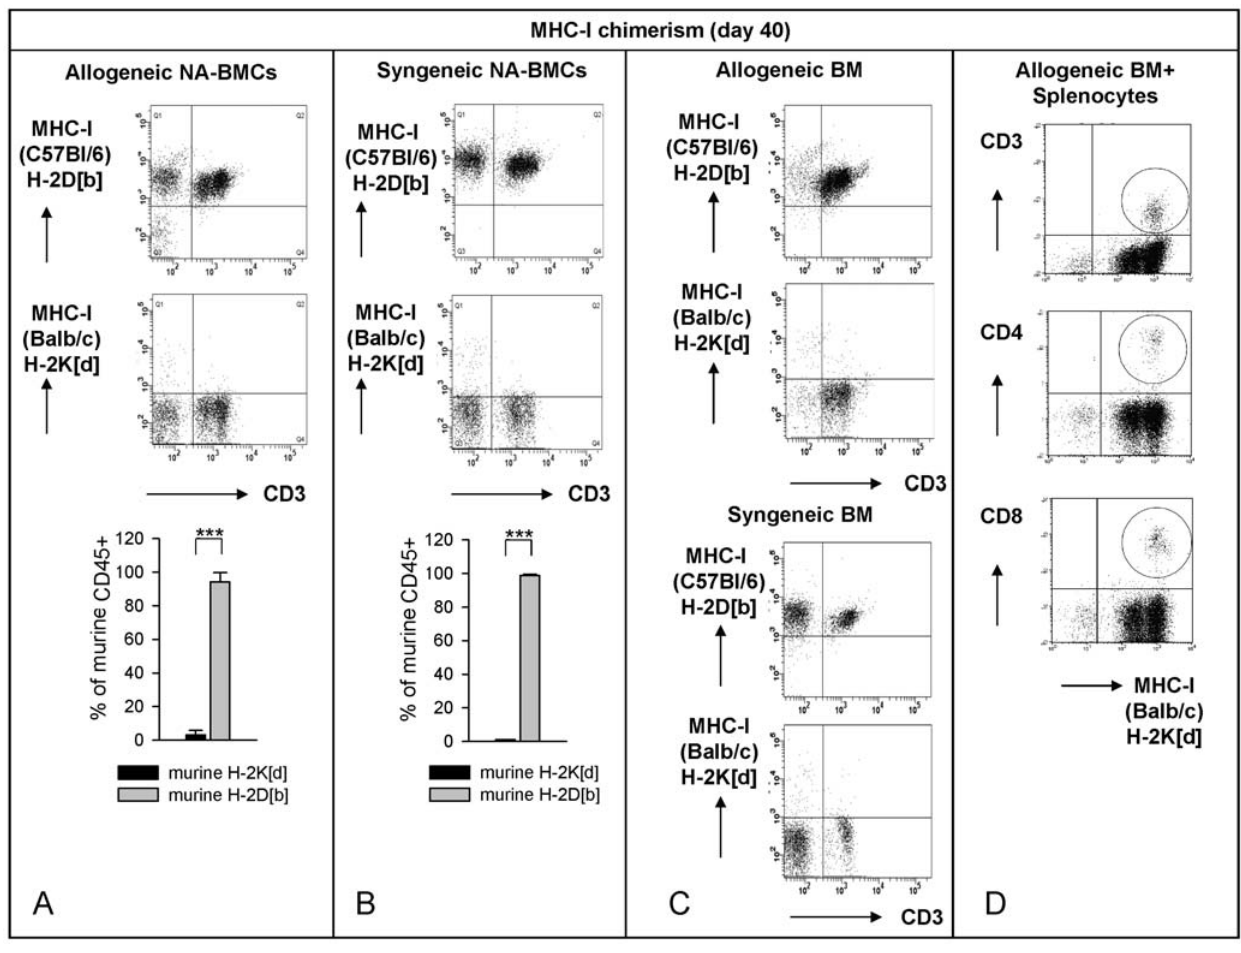
Figure 4. Flow cytometric analysis of MHC-I and CD3 on day -2 before and day 40 after transplantation. MHC-I (H-2D[b], H-2D[d]) and CD3 levels from peripheral blood (gated for lymphocytes) on day 40 after allogeneic NA-BMCs (A), syngeneic NA-BMCs (B) or allogeneic bone marrow (C) transplantation. In co-transplanted animals with allogeneic bone marrow and murine splenocytes we additionally analyze the murine CD4/H-2K[d] and CD8/H-2K[d] expression on bone marrow cells to show donor engraftment. doi:10.1371/journal.pone.0006157.g004 of GvHD and host versus graft (HvG) treatment strategies as well as for tolerance induction using monoclonal antibodies.